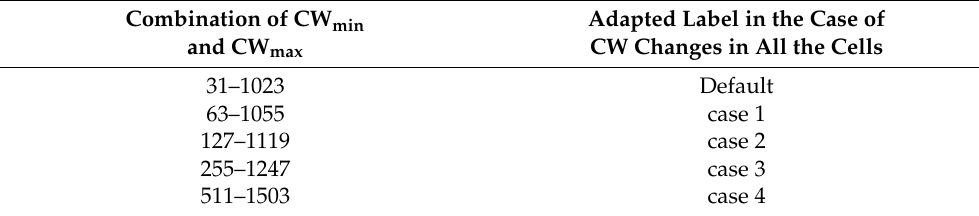
Table 8. Label adaptation of CW combinations to find the optimal point. Combination of CW